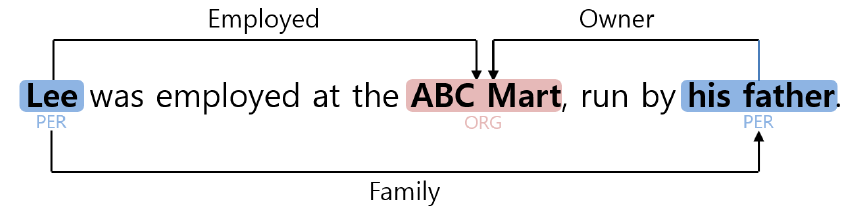
Figure 1. Subject-relation-object triples in a sentence. PER: person; ORG: organization.